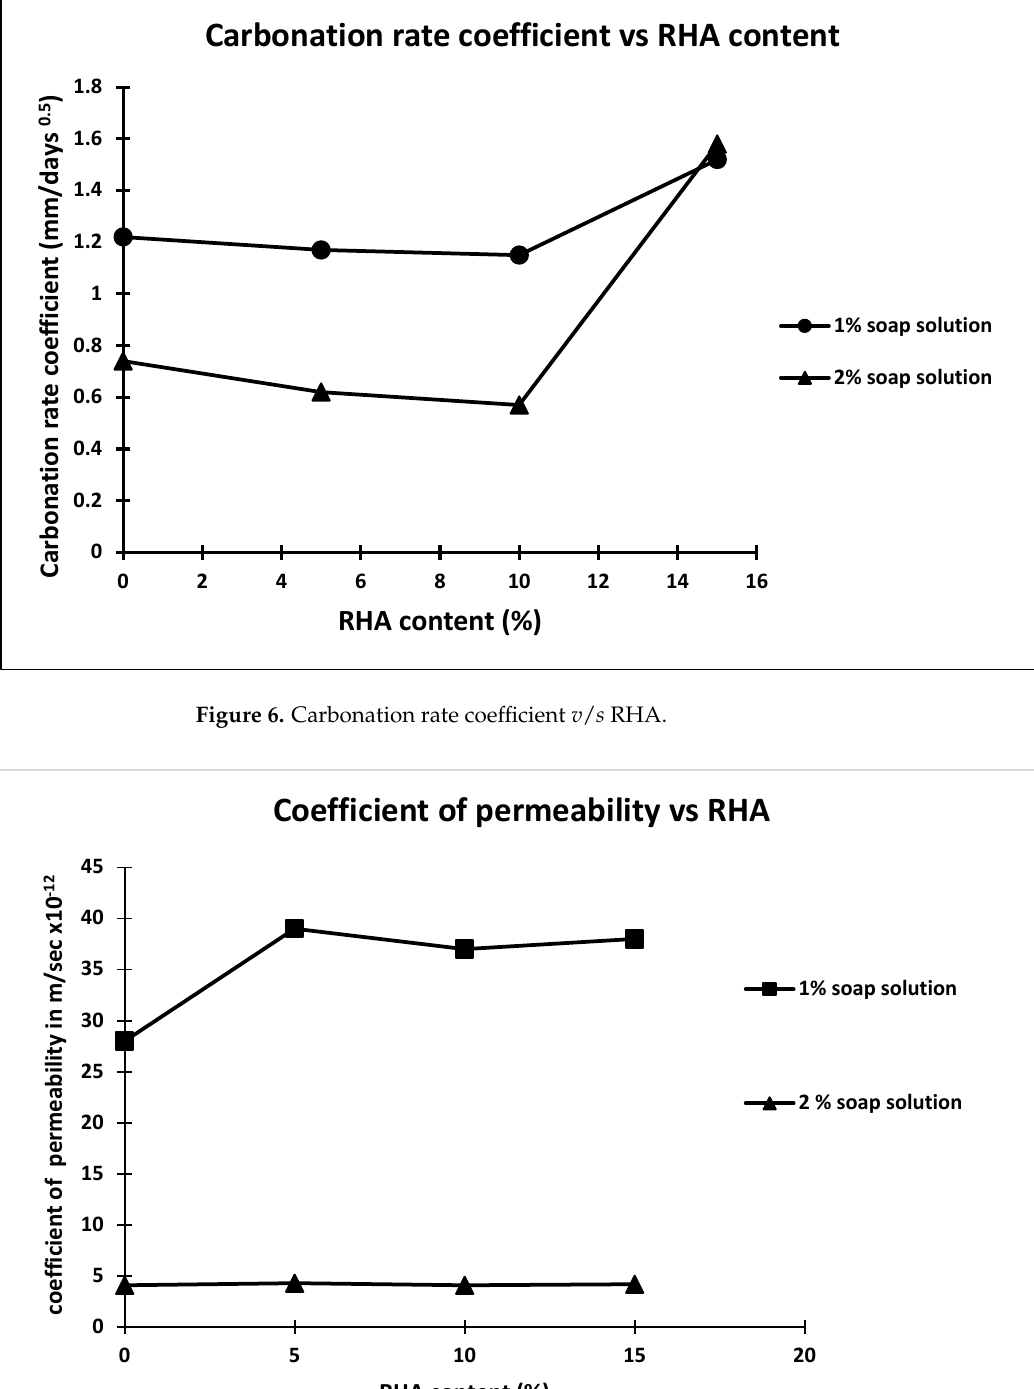
Figure 5. Relationship between compressive strength and carbonation depth.